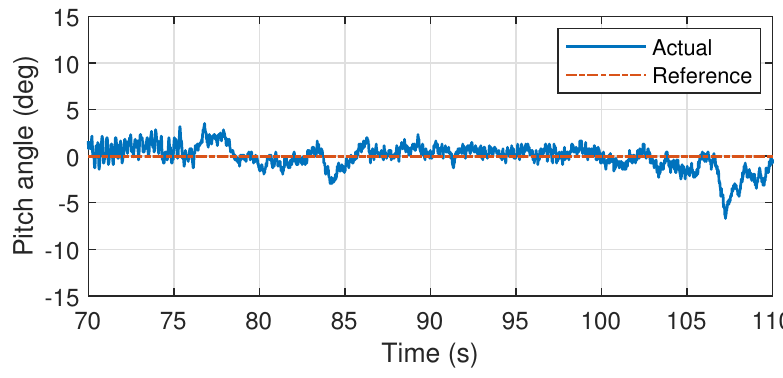
Figure 24. Pitch